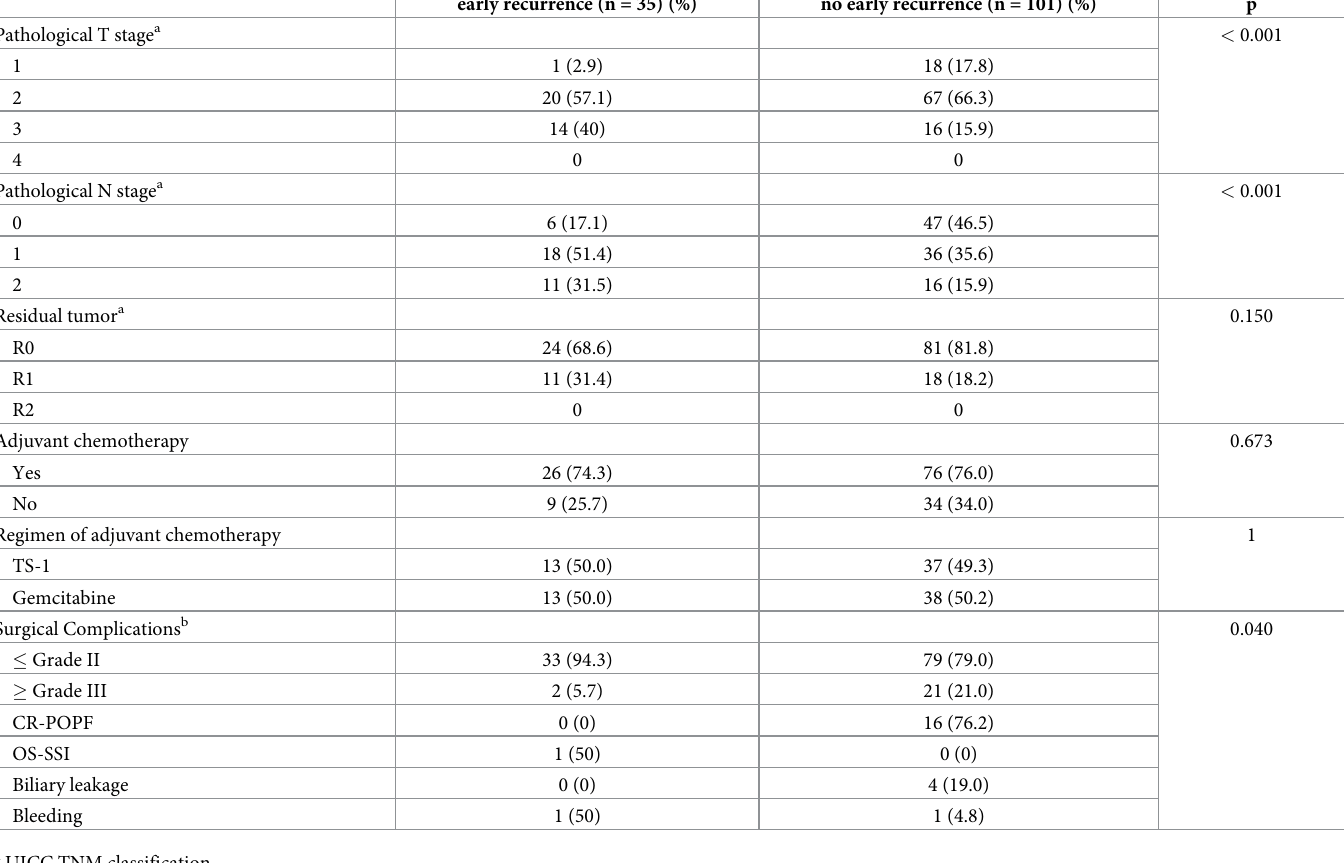
Table 4. Postoperative outcomes of patients who did or did not suffer early